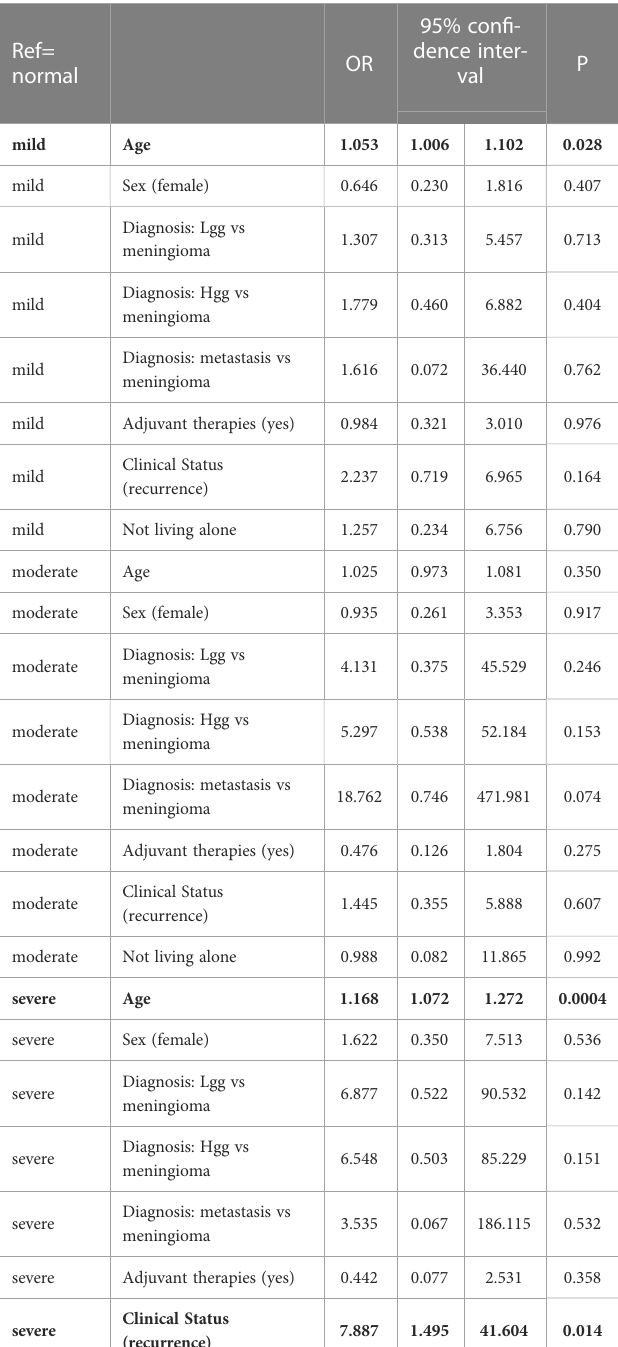
TABLE 2 Variables associated with psychological distress-Results of multinomial regression